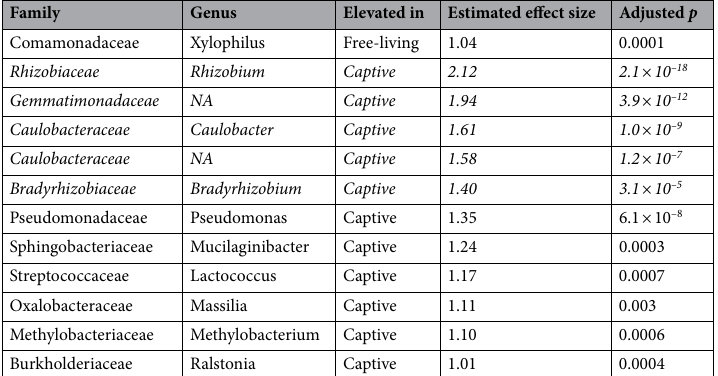
Table 4. Differentially abundant microbial taxa (estimated effect size ≥ 1) among free-living and captive song sparrows calculated via a generalized linear model in ALDEx2. Benjamini–Hochberg adjusted p-values are reported. Italics indicate the most highly distinguishable taxa. A graphical representation is available in the supplementary materials (Fig. S2).